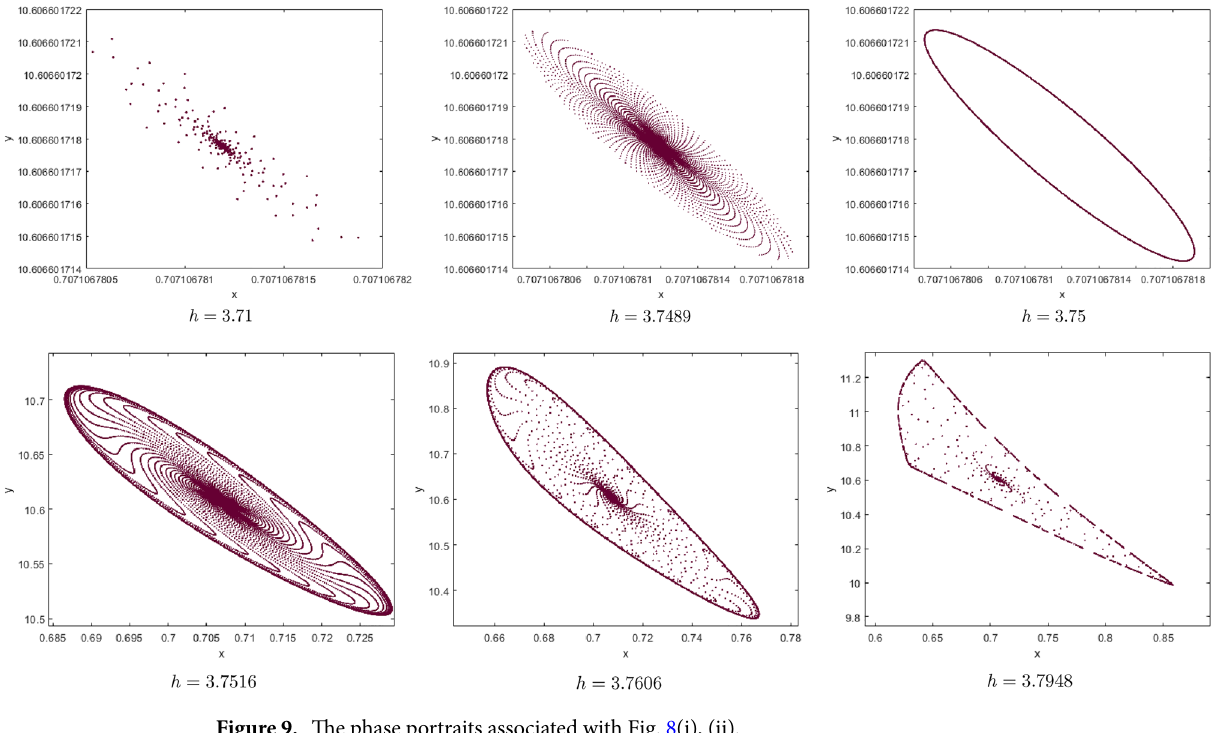
Figure 9. The phase portraits associated with Fig. 8(i), (ii). Value of bifurcation parameter when h > 3.7328